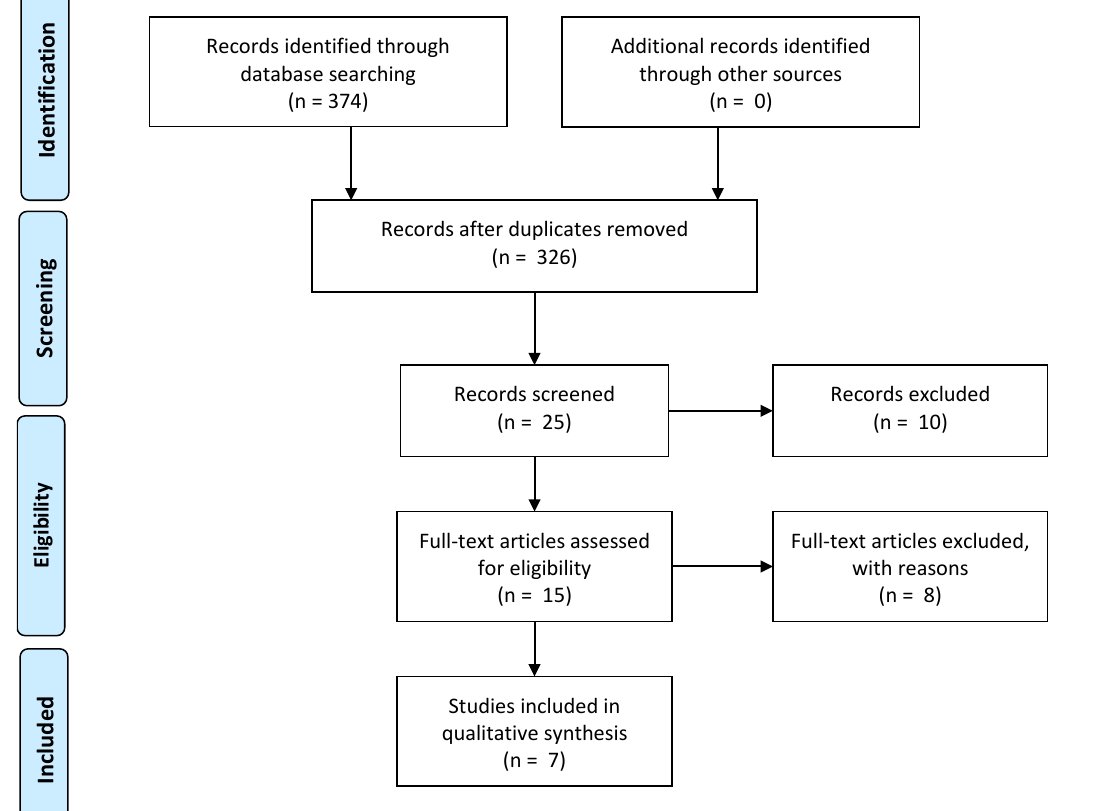
Figure 1. Preferred Reporting Items for Systematic Reviews (PRISMA) flow diagram .